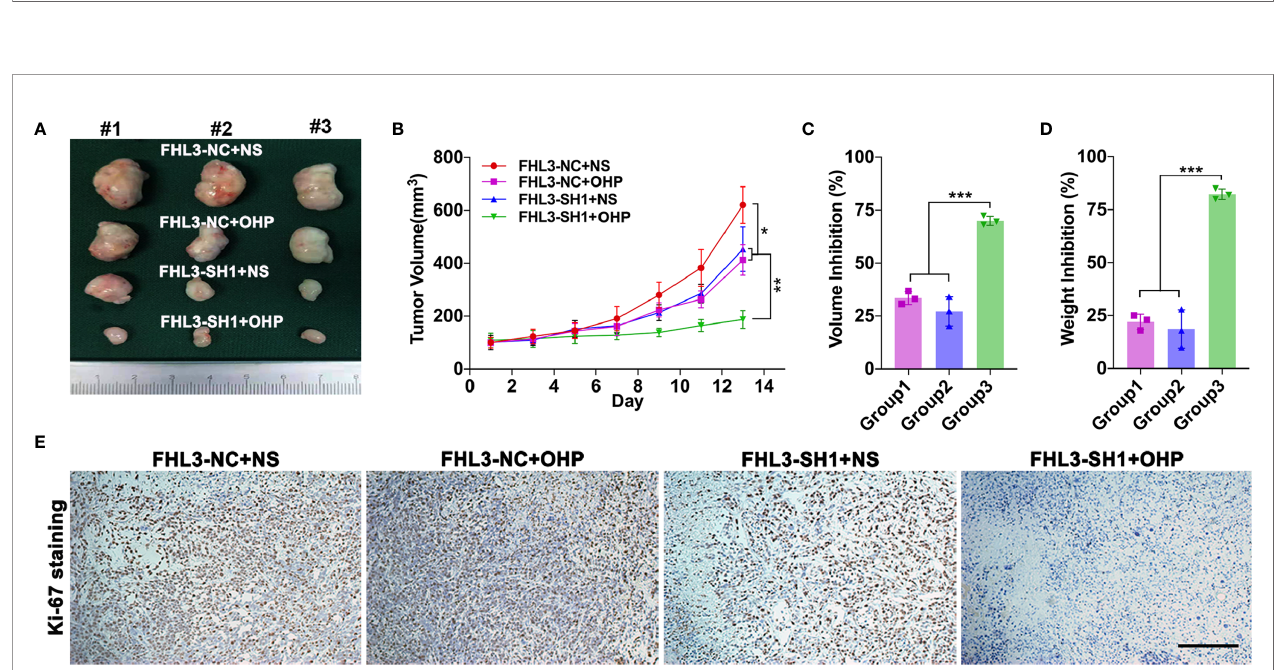
FIGURE 5 | FHL3-mediated gastric cancer OHP resistance was veri fi ed in subcutaneous tumor model. (1) The tumors were harvested, and the tumor volume and weight in vivo were investigated (A, C and D) , FHL3 knockdown could sensitize the ef fi cacy of OHP treatment and inhibit tumor growth; (2) Tumor volume variation during 14 days of OHP treatment (B) ; (3) The ki-67 staining assay (100× magni fi cation) was performed to show the cancer cell proliferation of every group (E)